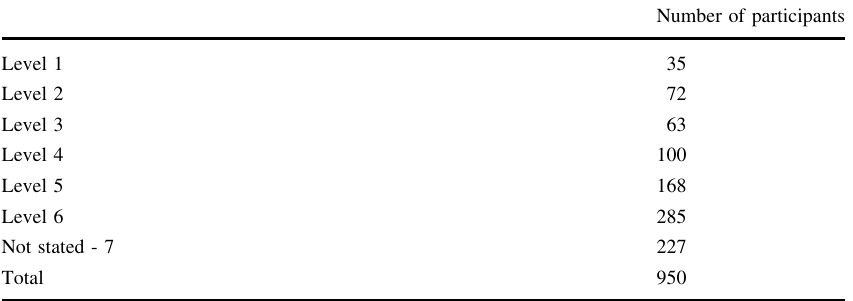
Table 1 Number of participants per hierarchy level